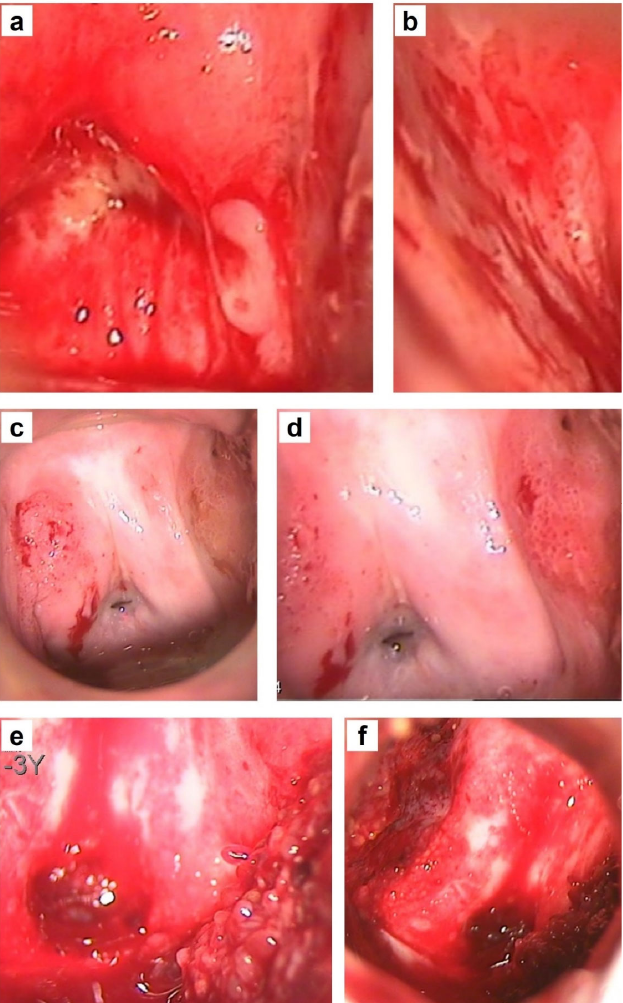
Figure 4. Heterogeneous colposcopic findings in women diagnosed with CV involvement from vulvar EMPD: ( a , b ) Dense acetowhite epithelium with sharp borders and coarse punctuation: inside the transformation zone of the cervix and in the left vaginal fornix ( a ); in the middle third of the left vaginal wall ( b ). ( c , d ) Micropapillary lesions with ridge sign and coarse punctuation: outside the transformation zone of the cervix ( c ); in the upper third of the left vaginal wall ( d ). ( e , f ) Large papillae with an irregular surface and fragile vessels: in the left vaginal wall ( e ); in the right and left vaginal walls with a wide extension ( f